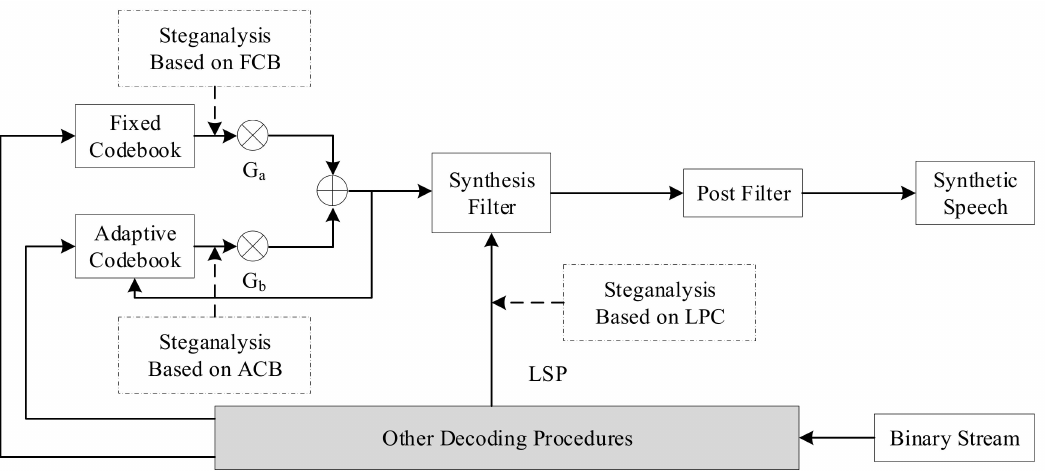
Figure 7. Distribution map of VoIP steganalysis based on voice